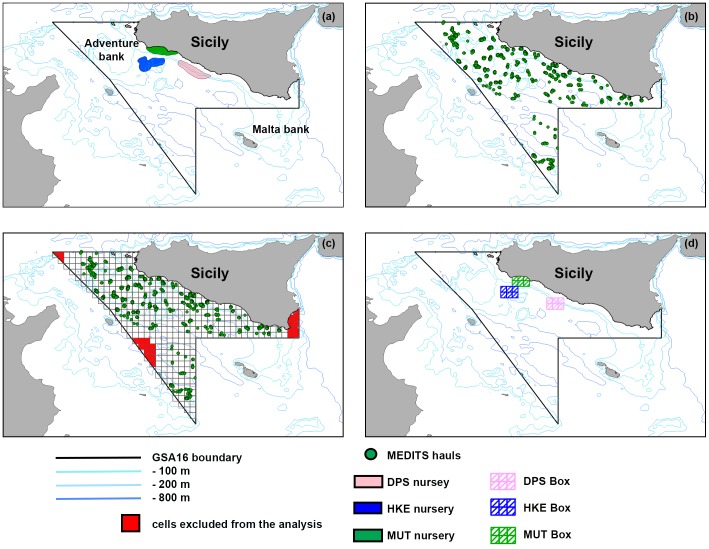
a) Map of the GSA16 (Strait of Sicily), with bathymetry represented by level line and nursery areas identified by [62]; b) positions (green points) of the Mediterranean International Trawl Survey (MEDITS) hauls, which are the sample design annually repeated during the survey; c) the grid (394 cells of size 6 min×6 min) used in the present study. Green points allows to identify cells containing MEDITS hauls, while cells not interpolated and excluded from the analysis are filled in red; d) Position of the three proposed boxes (overlapping nurseries) for fishing closure.